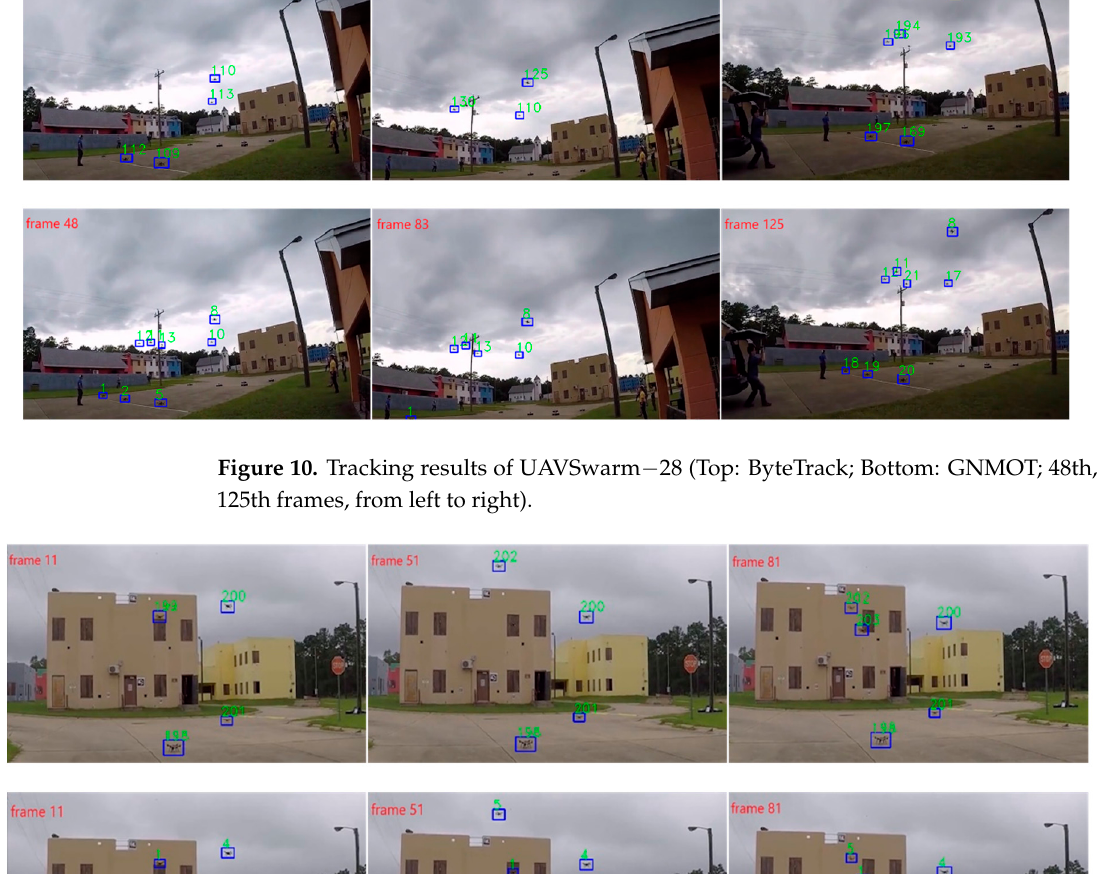
Figure 11. Tracking results of UAVSwarm − 30 (Top: ByteTrack; Bottom: GNMOT; 11th, 51st, and 81st frames, from left to right).